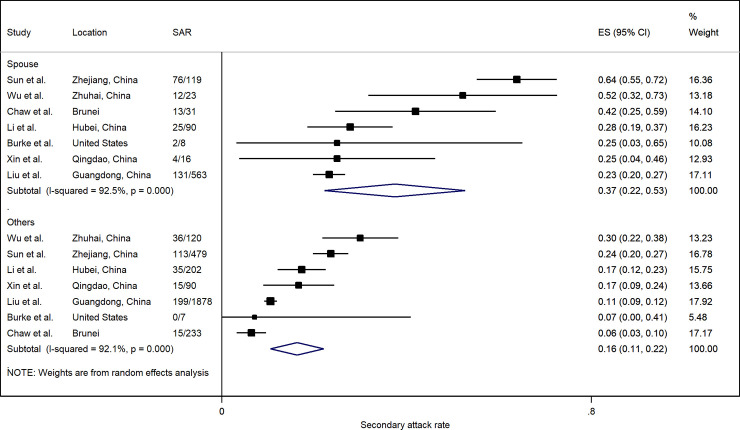
Forest plot of household secondary attack rates (SAR) by relationship to index case.ES is the estimated SAR, with 95% confidence intervals (CI). I-squared is the percentage of between-study heterogeneity that is attributable to variability in the true effect, rather than sampling variation.